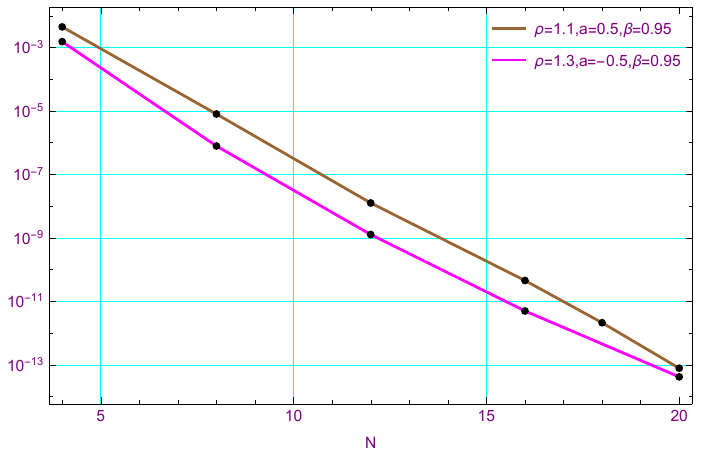
Figure 4. The maximum absolute errors of Example 4.